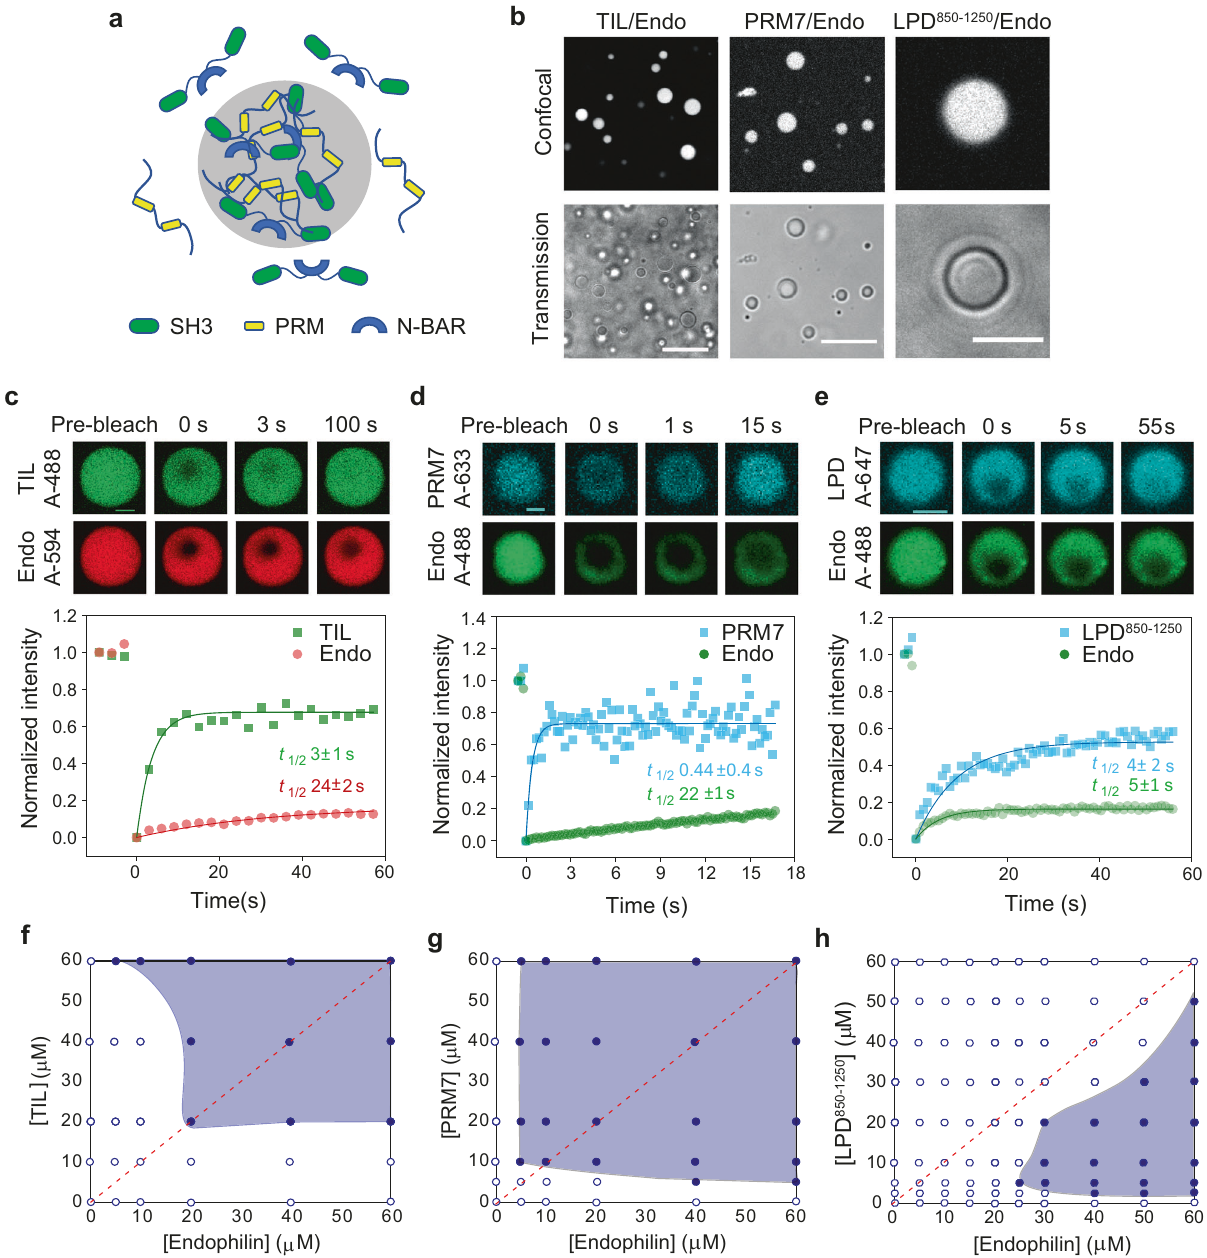
0102030405060 0 Fig. 3 | Endophilin undergoes LLPS through multivalent interactions with and TIL (Alexa 488). Recovery time constants ( t 1/2 ) for TIL (green) and endophilin proline-rich motifs in the absence of PEG. a Cartoon diagram illustrating that (red) were determined from single-exponential fi ts (solid lines) of the FRAP data multivalentinteractionbetweenSH3domainsofdimericendophilinandamultiple and have been reported as mean±s.d. of three independent FRAP experiments. d , e FRAP studies on PRM7/endophilin and LPD 850 – 1250 /endophilin droplets in the PRM containing ligand can drive LLPS. b Confocal fl uorescence images (top) and presence of endophilin-Alexa 488, PRM7-Alexa 633, and LPD 850 – 1250 -Alexa 647. transmission images (bottom) of droplets formed by the TIL/endophilin, PRM7/ Recovery time constants ( t 1/2 ) for PRM7, LPD 850 – 1250 (cyan), and endophilin (green) endophilin, and LPD 850 – 1250 /endophilin system. The TIL/endophilin and PRM7/ endophilin droplets were formed in the presence of 100 µ M of endophilin and have been reported as mean±s.d. of three independent FRAP experiments. Scale 100 µ MofeitherTILorPRM7with1 µ Mof eitherTIL-Alexa488orPRM7-Alexa633. bars 2 µ m ( c – e ). f – h Phase diagrams for TIL/endophilin ( f ), PRM7/endophilin ( g ), TheLPD 850 – 1250 /endophilindropletswereformedbymixing20 µ MofLPD 850 – 1250 and andtheLPD 850 – 1250 /endophilin( h )LLPSsystems.Thereddottedlinerepresentsthe 60 µ M ofendophilin and contained 1 µ M ofLPD 850 – 1250 -Alexa 647.Scale bars 20 µ m. axis of a 1:1 mixing ratio of both proteins. All experiments were performed in c Confocalimagesandintensitypro fi lesfromarepresentativeFRAPexperimenton 20mM HEPESbuffer, 150mM NaCl,1mM TCEP, pH 7.4, and a TIL ‒ endophilin droplet to monitor the mobility of both endophilin (Alexa 594)